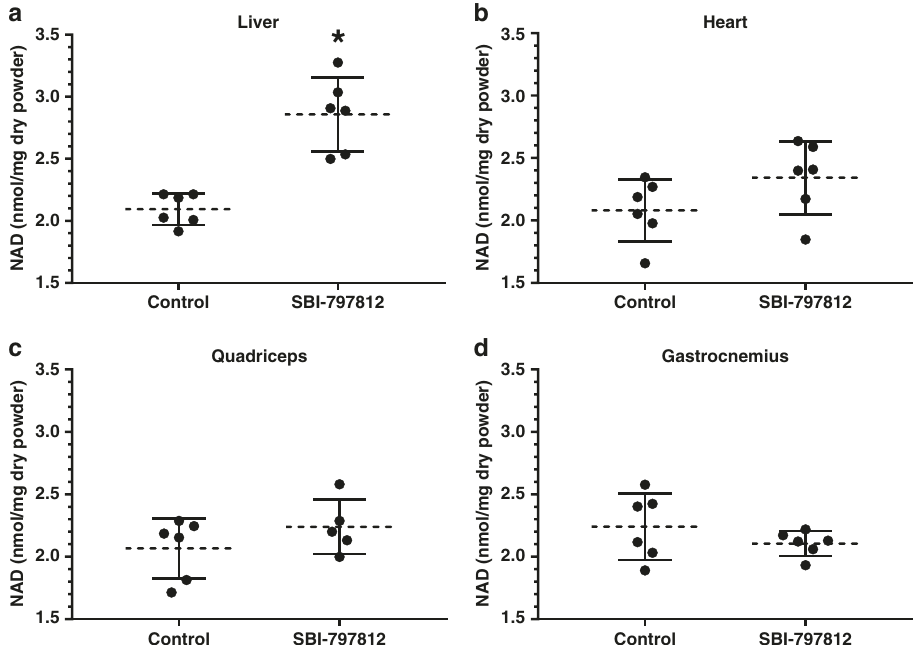
Fig. 6 Effects of SBI-797812 on tissue NMN and NAD + in mice. SBI-797812 (20 mg kg − 1 ) or vehicle were dosed to mice by i.p. administration. Liver ( a ), heart ( b ), gastrocnemius ( c ), and quadriceps ( d ) were harvested at 4 h post-dosing. Tissues were assayed for NAD + (which was normalized to mg of dry tissue) by LC-MS/MS. Data shows means ± s.d.; n = 6 except for quadriceps (SBI-797812),which was n = 5. * p = 0.0002 vs. Control. Two-tailed unpaired t tests were used. Source data are provided as a Source Data fi